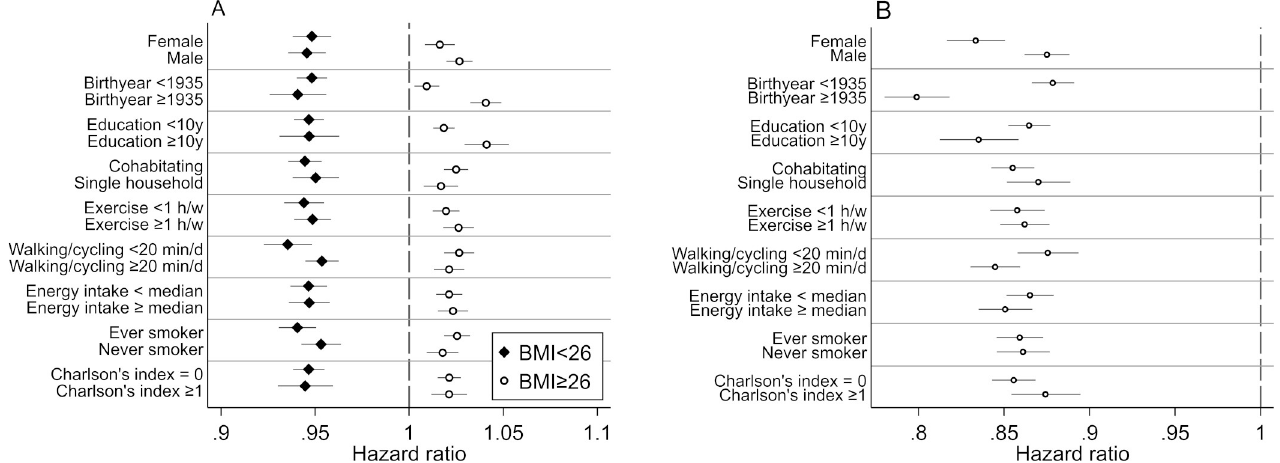
Fig 2. Subgroup analysis for BMI as continuous variable below or above the median of 26 kg/m 2 (A) and for mMED (B) as a continuous variable by categories of the covariates. The whiskers represent 95% CIs. Associations expressed as multivariable-adjusted HRs of all-cause mortality by 1 unit change in BMI or mMED score. HRs adjusted for sex, age (splines with 2 knots), educational level ( � 9, 10–12, > 12 years, other), living alone (yes or no), leisure time physical exercise during the past year ( < 1 h/w, 1 h/w, 2–3 h/w, 4–5 h/w, > 5 h/w), walking/cycling (almost never, < 20 min/d, 20–40 min/d, 40–60 min/d, 1–1.5 h/d, > 1.5 h/d), height (splines with 2 knots), energy intake (splines with 2 knots), smoking habits (current, former, never), Charlson’s weighted comorbidity index (continuous; 1–16), and diabetes mellitus (yes/no). BMI, body mass index; CI, confidence interval; HR, hazard ratio; mMED, modified Mediterranean- like